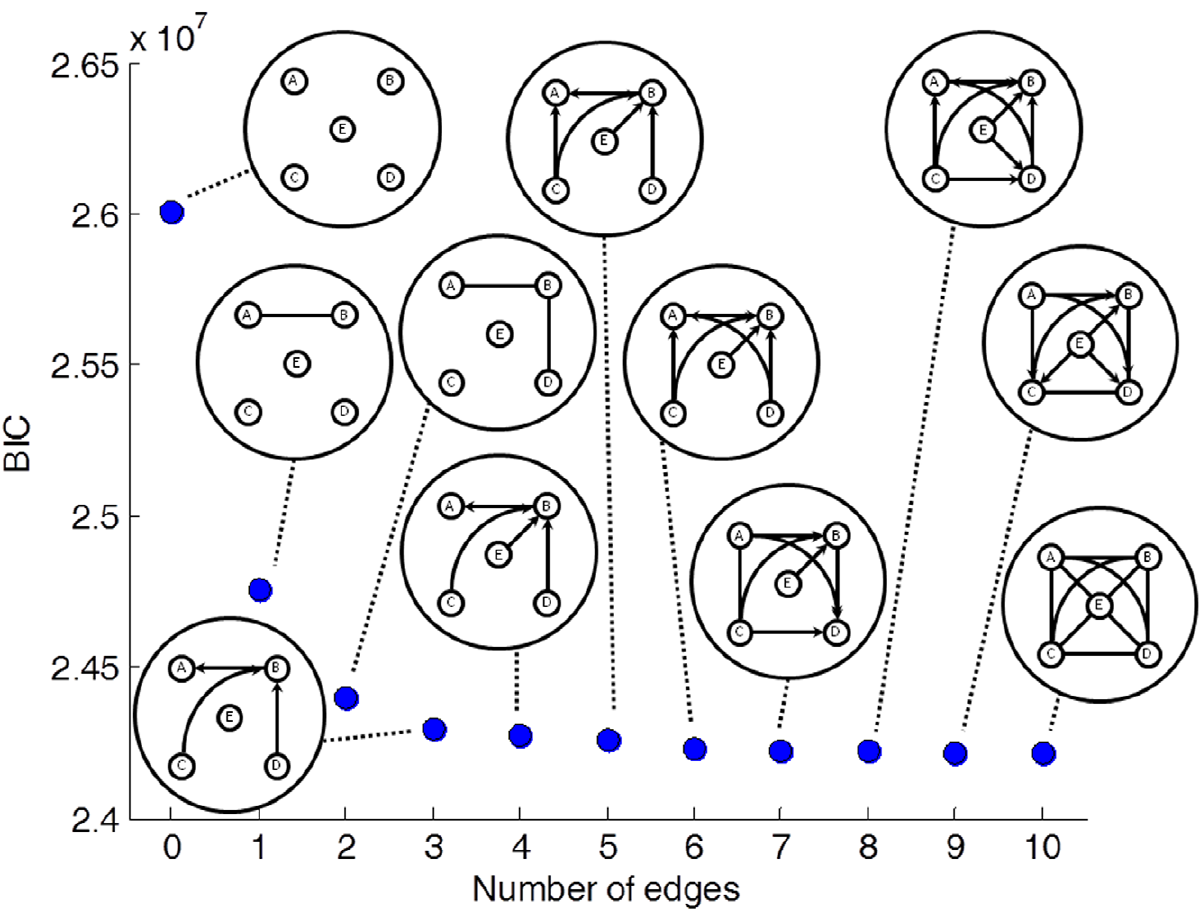
Figure 3. BIC scores (dots) and pDAGs of rat models M 1 through M 10 . The designations are as in Figure 2. The number of parameters required to describe each of the models is 5 ( M 0 ), 6 ( M 1 ), 7 ( M 2 ), 9 ( M 3 ), 13 ( M 4 ), 15 ( M 5 ), 23 ( M 6 ), 20 ( M 7 ), 26 ( M 8 ), 30 ( M 9 ), and 31 ( M 10 ).